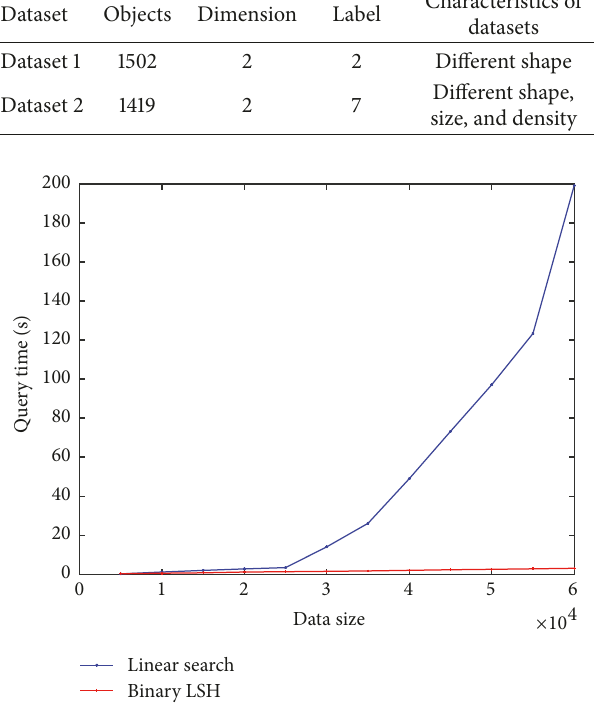
Figure 3: Comparison of query time.